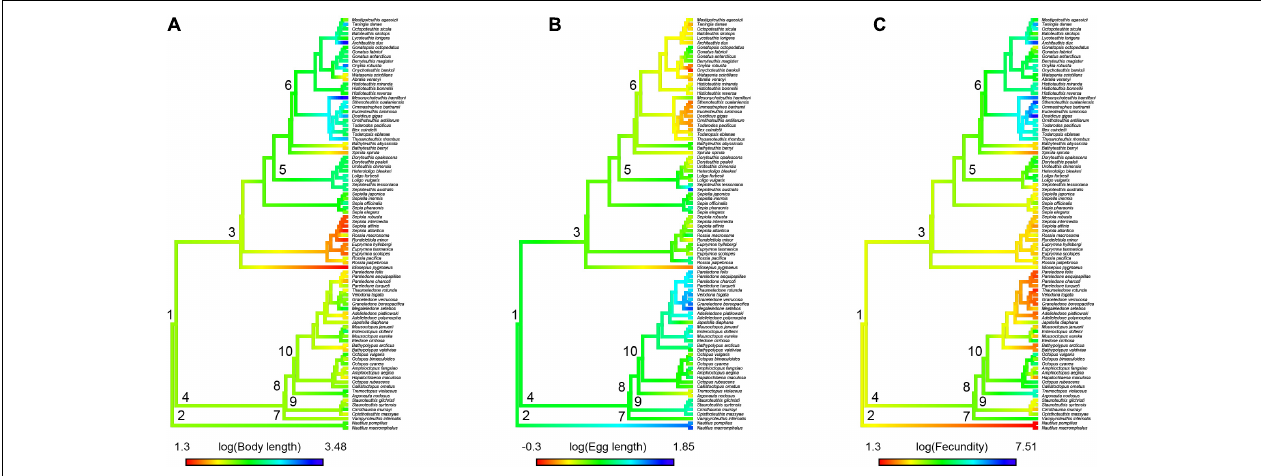
FIGURE 4 | Density map of ancestral reconstruction of 90 cephalopod species, where (A) body length, (B) egg length, and (C) potential fecundity. The number in each node correspond to: (1) subclass Coleoidea, (2) subclass Nautiloidea, (3) superorder Decapodiformes, (4) superorder Octopodiformes, (5) order Myopsida, (6) order Oegopsida, (7) order Cirrata, and (8) order Incirrata, (9) superfamily Argonautoidea, (10) superfamily